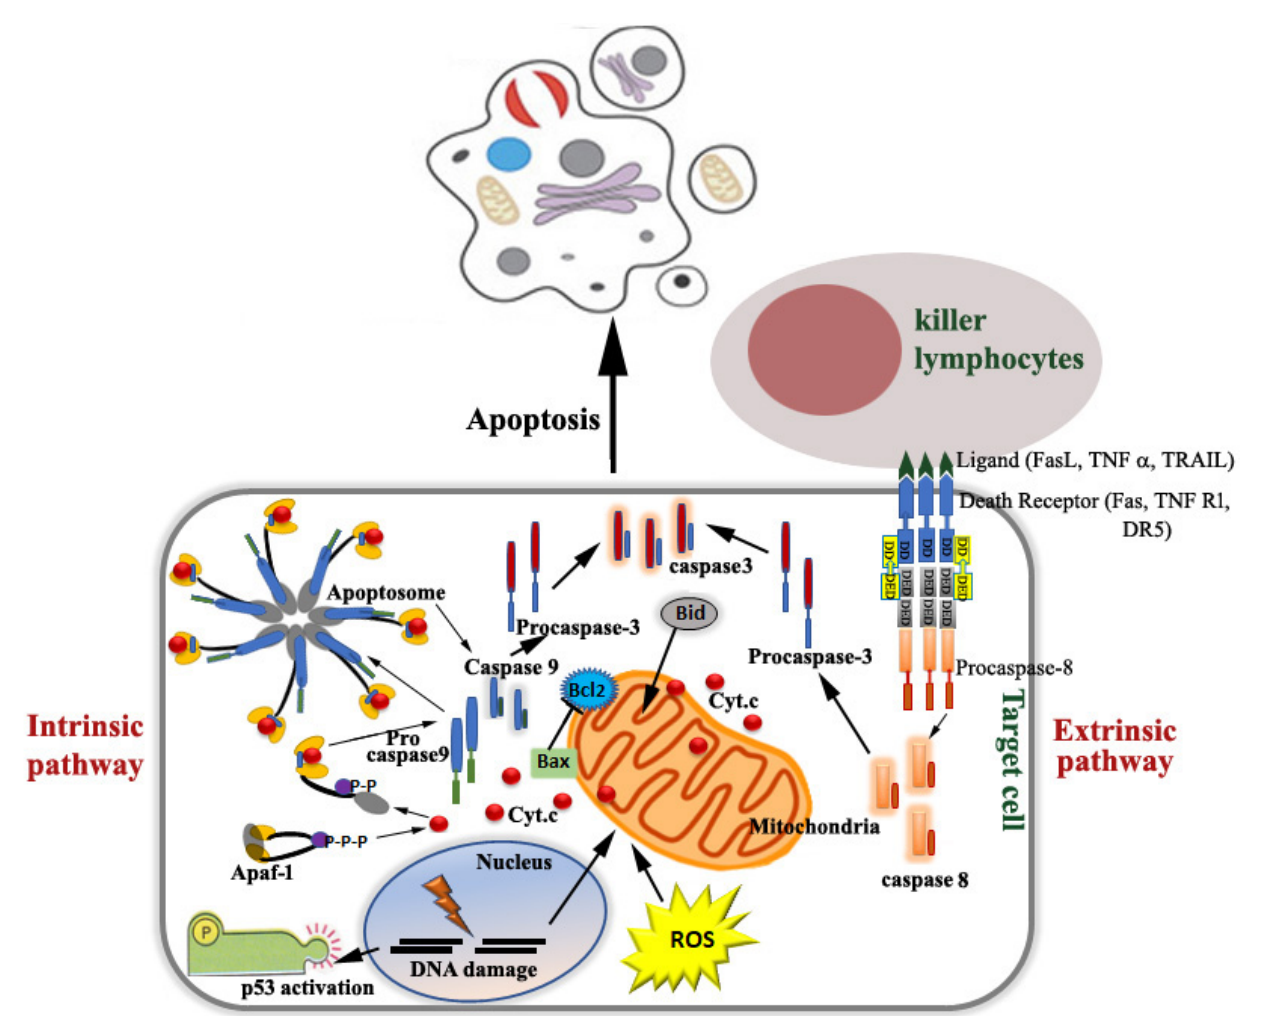
Figure 1. A schematic representation depicting the molecular pathways with the biomarkers of caspase-dependent programmed cell death: intrinsic and extrinsic pathways. [The intrinsic pathway (LHS in the figure) begins inside a cell that is mitochondrial-mediated, where apoptosis is initiated when cellular stresses caused by damage of DNA, shock due to heat and oxidative stress, causing the release of cytochrome c or Smac/DIABLO from the mitochondrial intermembrane space to the cytosol, takes place. Release of cytochrome c is achieved by Bcl2 protein family (Bax, Bid), which translocate to the mitochondria, and/or oligomerize within mitochondrial membranes, forming pores which in turn releases cytochrome c to the cytoplasm from the mitochondrial in- termembrane space. Released cytochrome c, in turn, binds to Apaf-1, a cytosolic protein that nor- mally exists as an inactive monomer. The binding of cytochrome c induces a conformational change in Apaf-1, allowing it to bind the nucleotide dATP or ATP. The nucleotide binding to the Apaf-1–cytochrome c complex triggers its oligomerization to form the apoptosome (a high molec- ular weight heptameric compound). Apoptosome activates caspase-9, which then cleaves, and thereby, activates the effector caspases, caspases-3 and -7. DNA damage and other stress signals may trigger the increase of p53 proteins. The extrinsic pathway (RHS in the figure) begins outside a cell that is receptor-mediated and initiated by receptor ligation, trimerization and recruitment of adapter molecules like FADD and TRADD to the death domain (DD), forming a complex known as the death-inducing signaling complex (DISC). Procaspase-8 then binds to the death effector do- mains (DED) of the adaptor molecules, which is then followed by oligomerization and activation of caspase-8. Caspase-8 then either directly activates the executioner caspases-3 and -7 or activates the cytosolic protein, Bid, to translocate into the mitochondria, causing the release of cytochrome c].